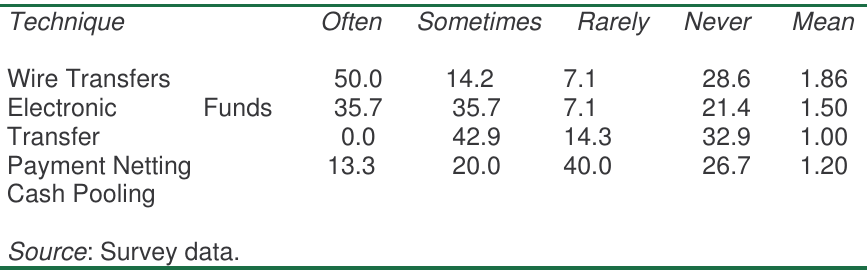
Table 3: International Cash Management